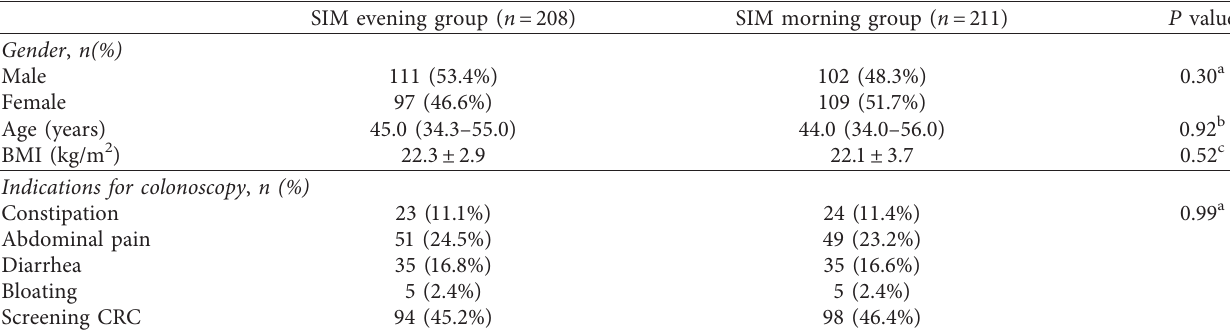
Table 1: Baseline characteristics.